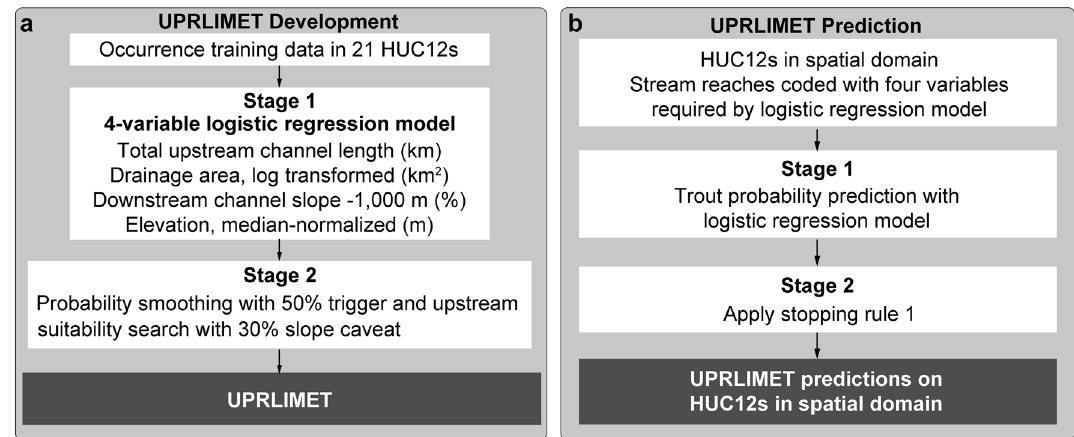
Figure 2. UPRLIMET ( a ) generalized development workflow and ( b ) prediction workflow. We constructed and compared 26 models to select the top performing model, termed UPRLIMET, based on the lowest overall error between observed and predicted upper extent of trout distributions across western Oregon. ( a ) Generalized development workflow for UPRLIMET, a single logistic regression model fit to trout occurrence observation data. Stage 1 involved fitting the 4-variable logistic regression to the occurrence observation data. Stage 2 included implementing Stopping Rule #1 (Fig. S1). ( b ) Generalized prediction workflow where the two-stage UPRLIMET prediction process is applied to all HUC12s in our study area producing a trout distribution map. The four environmental predictor variables in a and b are characterized at the scale of the individual reach (5–7 m) and derived from a 5-m LiDAR-derived digital elevation model (Data